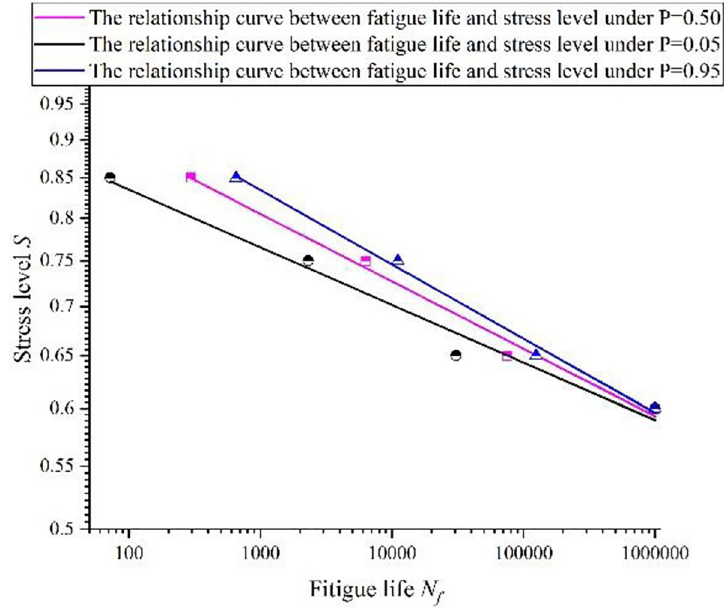
Fig 5. The relationship curve between fatigue life and stress level with different failure probability.